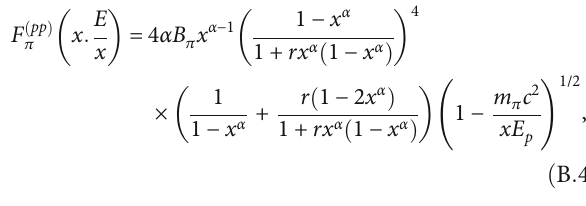
ffiffiffiffiffi α ′